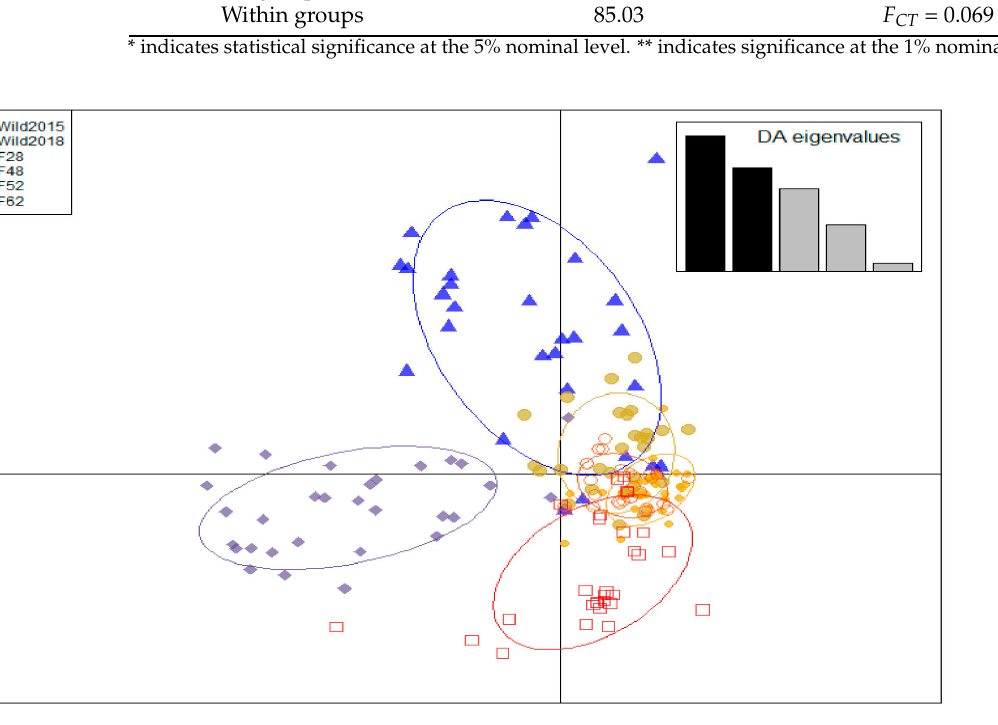
Figure 3. Discriminant analysis of principal components (DAPC) plot of six cohorts from two Hermetia illucens populations. Each cohort is represented by a unique shape and